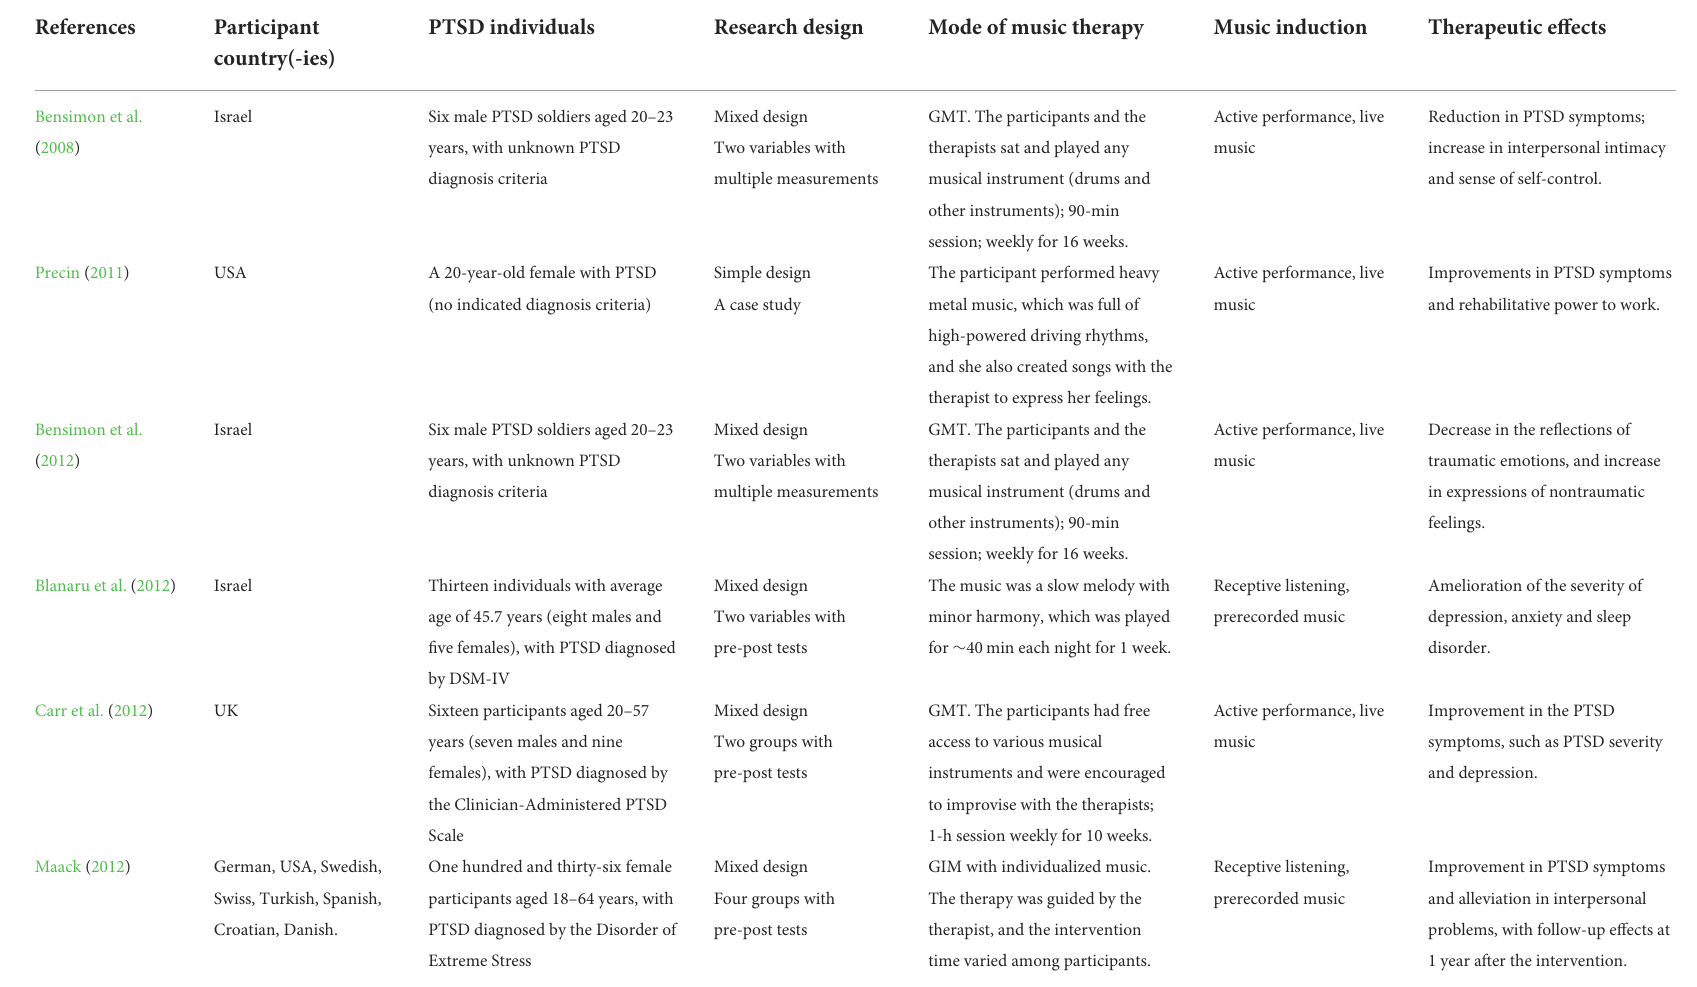
TABLE 3 Examples of music therapy for the patients of post-traumatic stress disorder